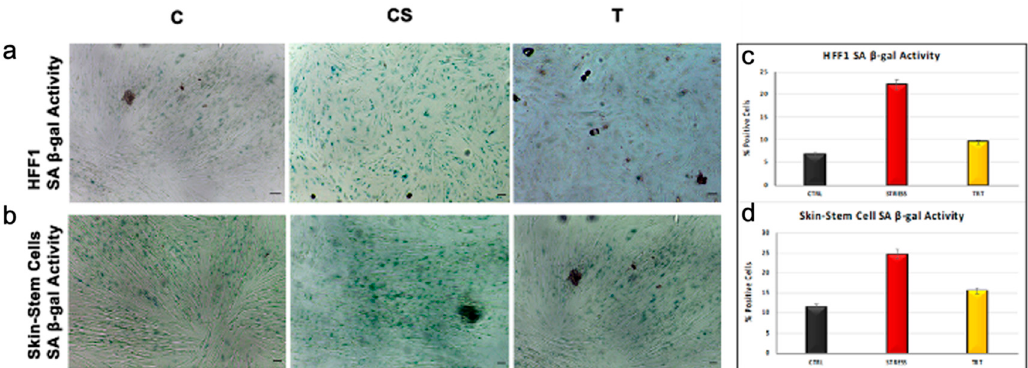
Figure 5. Senescence-associated β -galactosidase activity evaluated in HFF1 ( a ) and skin stem cells ( b ) after seven days. Cells pretreated with NanoPCL-M (T) are compared to control untreated cells (C) and UV stress control (CS). Scale bar = 100 µm. The number of blue positive HFF1 ( c ) and skin stem ( d ) was calculated using ImageJ. Data are expressed as mean ± SD.